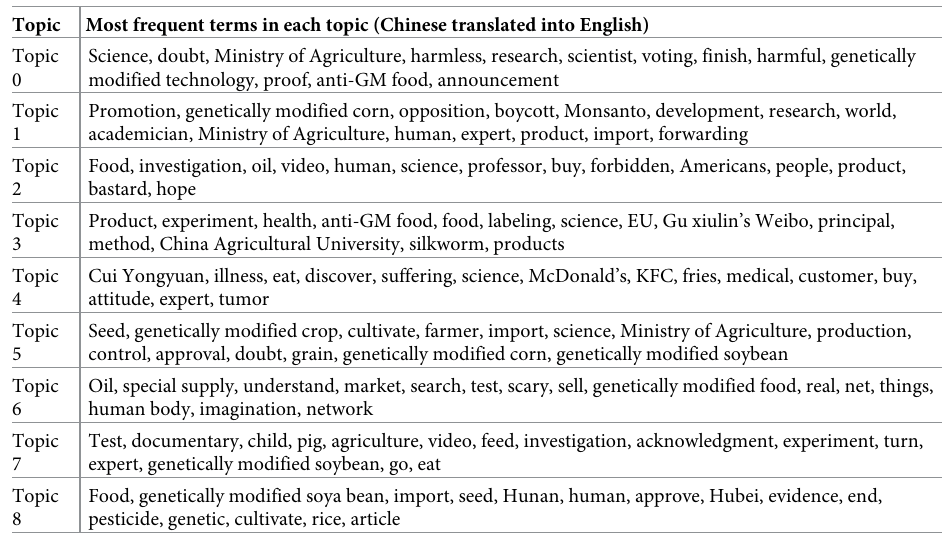
Table 2. Topics of GM food obtained through